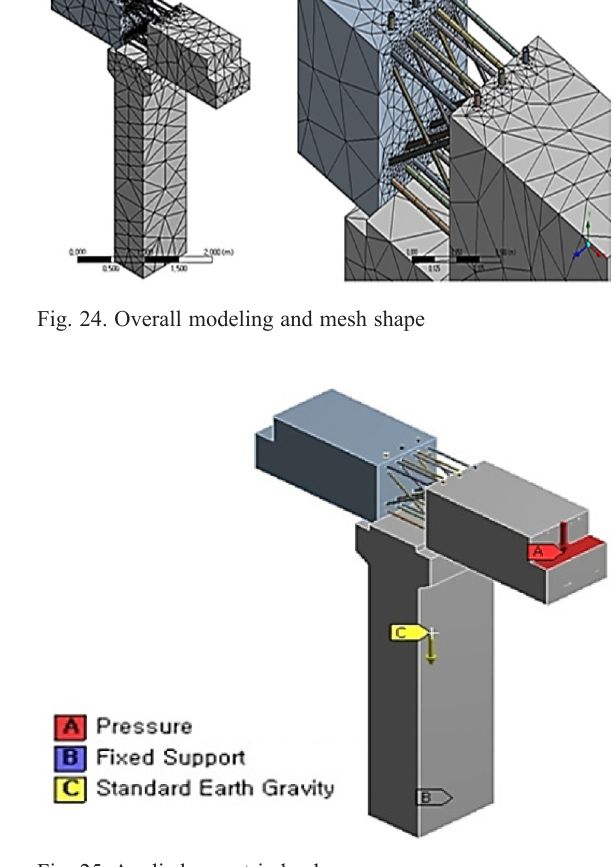
Fig. 25. Applied eccentric